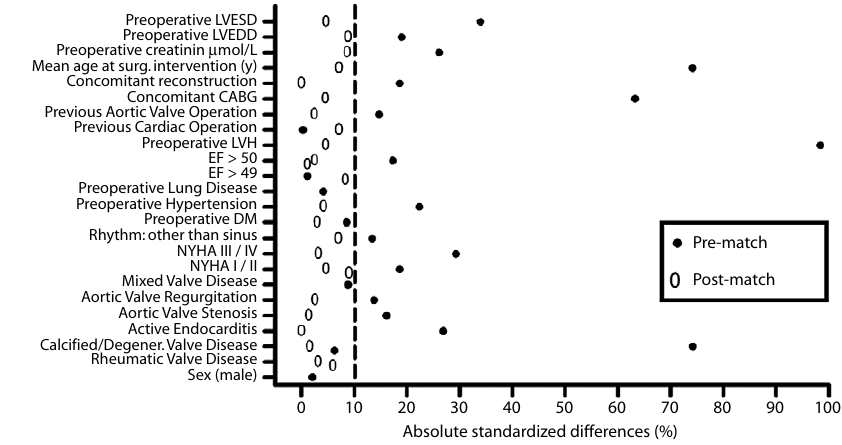
Figure. 2 Love plots for absolute standardized differences for baseline covariates between patients with the Ross procedure, before and after propensity score matching. DM indicates diabetes mellitus; EF, left ventricular ejection fraction; CABG, coronary artery bypass grafting; MV, mitral valve; and LVEDD, left ventricular end- diastolic diameter; LVESD, left ventricular end-systolic diameter; LVH, left ventricular hypertrophy; and NYHA, New York Heart Association. Reproduced with permission from Ref. [8].